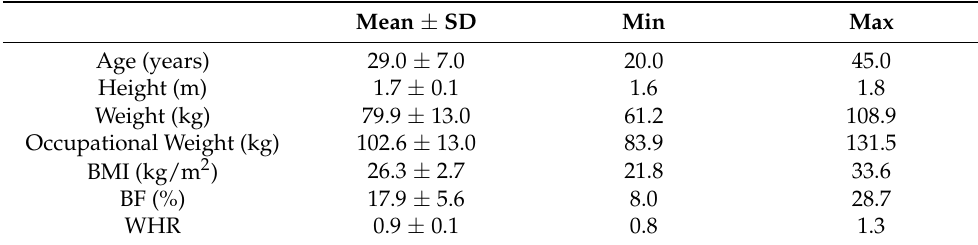
Table 1. Descriptive Statistics—Anthropometrics & Body Composition.